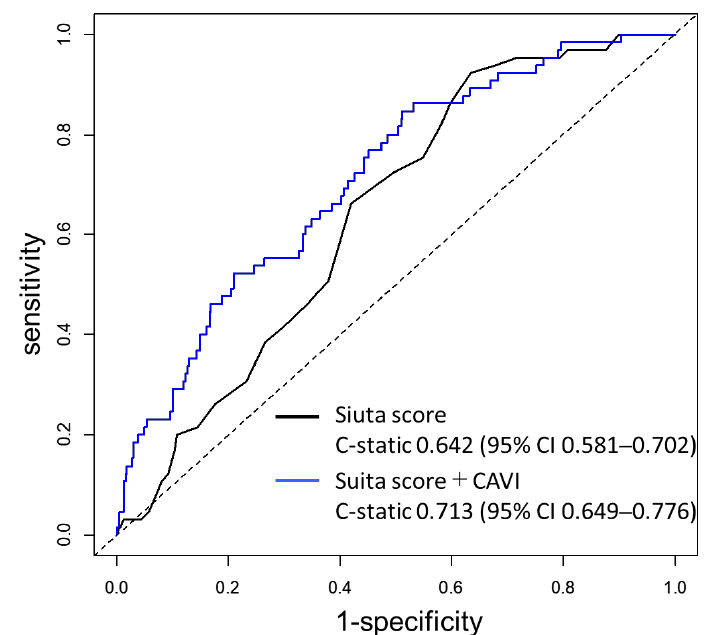
Figure 3. Comparison of the receiver-operating characteristic (ROC) curves. Black curve: predictive ability based on the Suita score. Blue curve: predictive ability based on the Suita score and CAVI. CI: confidence interval.